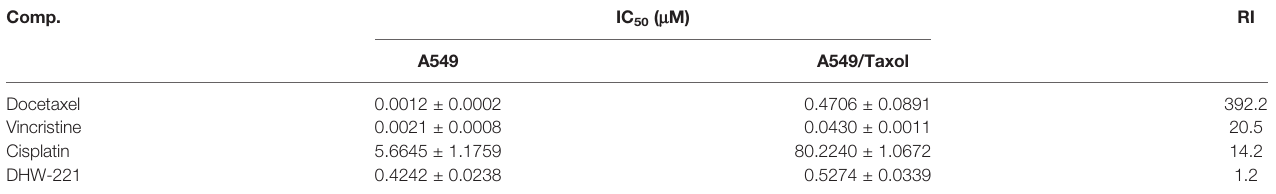
TABLE 1 | The resistance index (RI) for various compounds at 72 h in A549/Taxol cells (mean ± SD, n = 3).